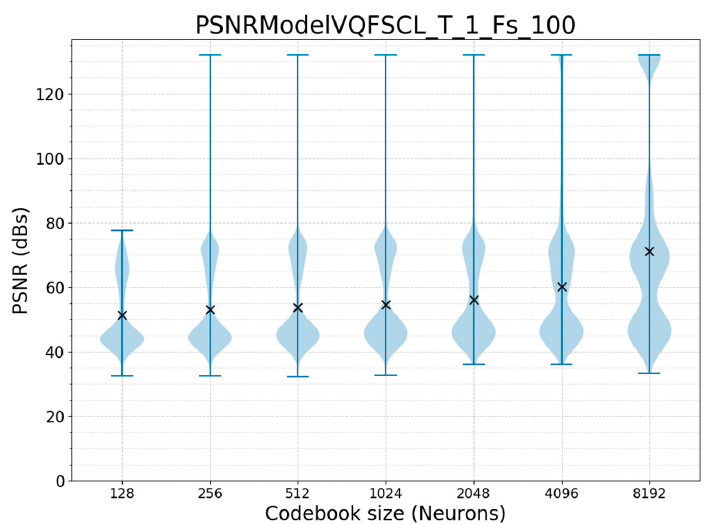
Figure 10. PSNR distribution and mean value (x) vs. codebook size N for the frequency sensitive competitive learning (FSCL) model (F = 100 Hz, T = 1 s).